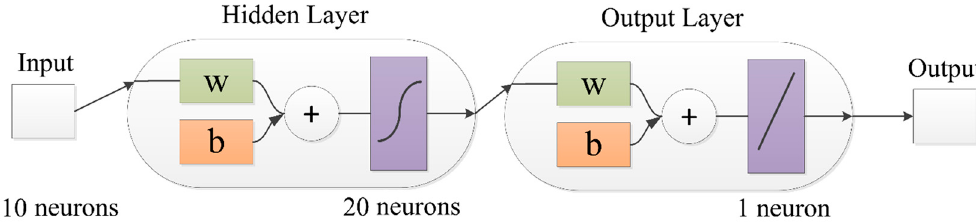
Figure 2. Structure of an artificial neural network (ANN) model. Weight matrix vector and threshold vector are denoted by w and b , respectively.